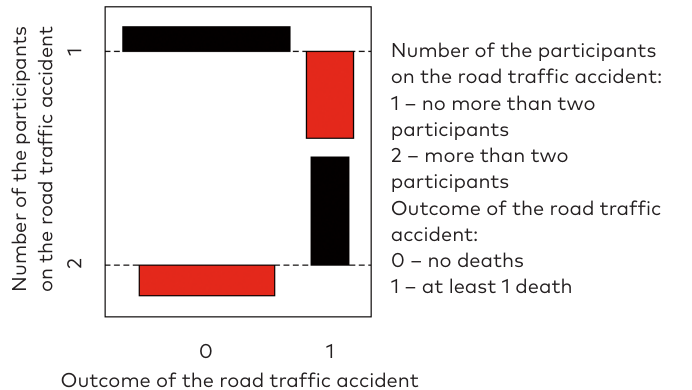
Figure 2. Association plot for categorical variables based on the number of the participants